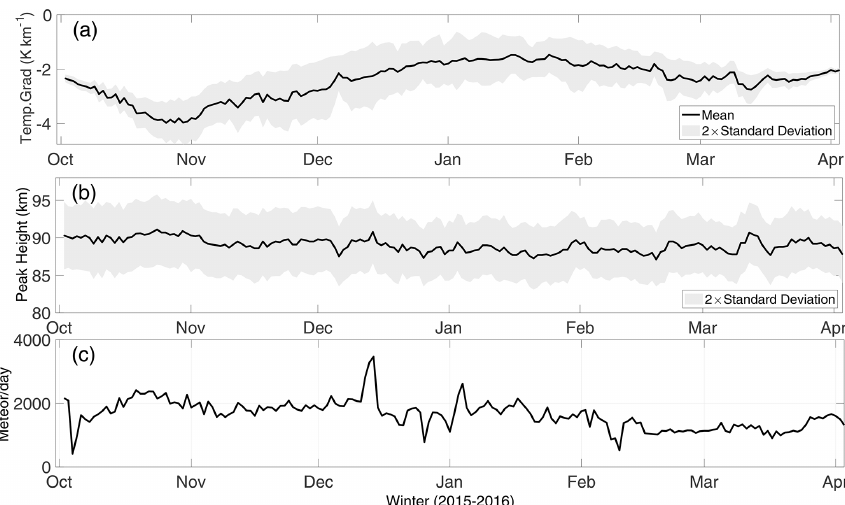
Figure 2. (a) Temperature gradient model derived from MSIS90. (b) Peak meteor heights for the data used in this work and (c) the daily meteor detection for zenith angle less than 50 ◦ and velocity in the range ± 100ms − 1